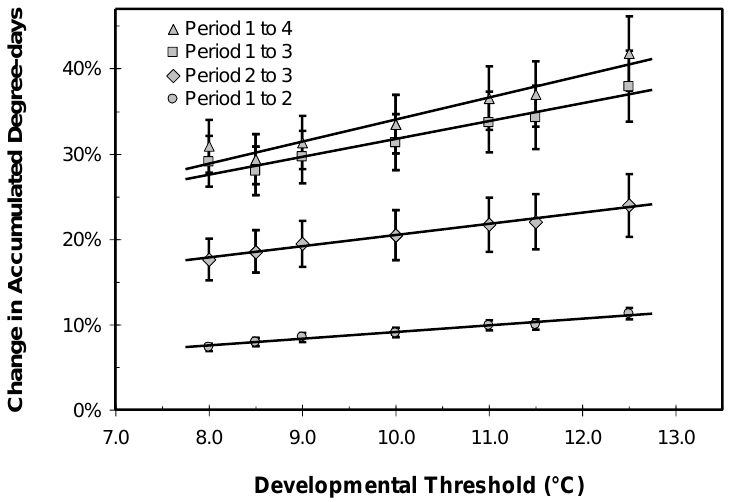
Figure 8. The percentage change ( ± standard error) in degree-day accumulations increases with developmental threshold. Both the intercept and the gradients increased when Period 1 is compared with Periods 2, 3 and 4. The largest increases in degree-day accumulations occurred in the interval Period 2–3. Data presented here are for all nine species studied, each with a different developmental threshold.